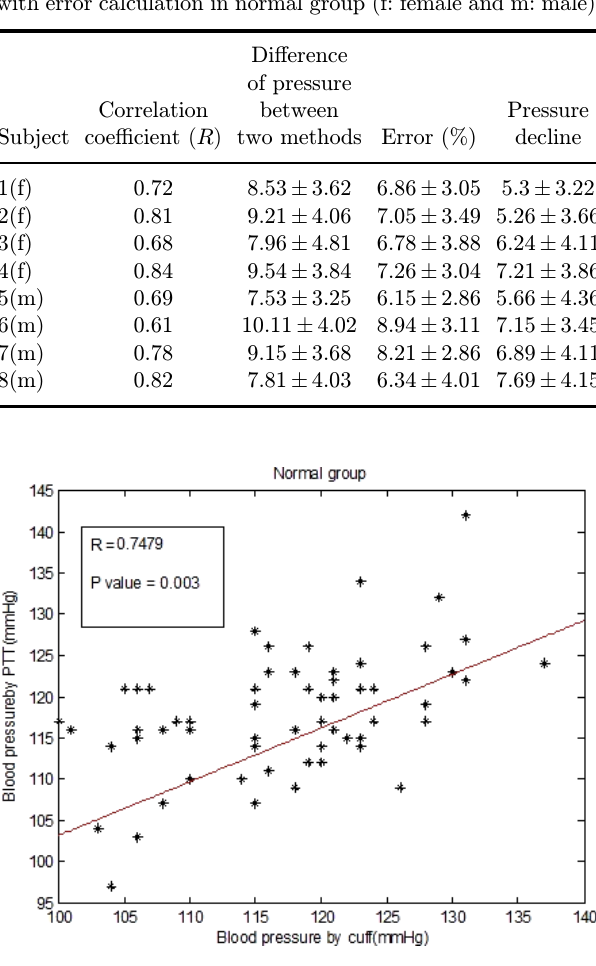
Table 1. The correlation coe±cient between SBP and PTT with error calculation in normal group (f: female and m: male).